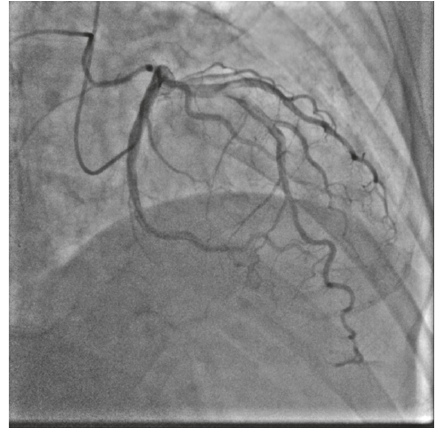
Figure 7: Angiography after fenestration showed Thrombolysis in Myocardial Infarction 3 (TIMI-3) flow.